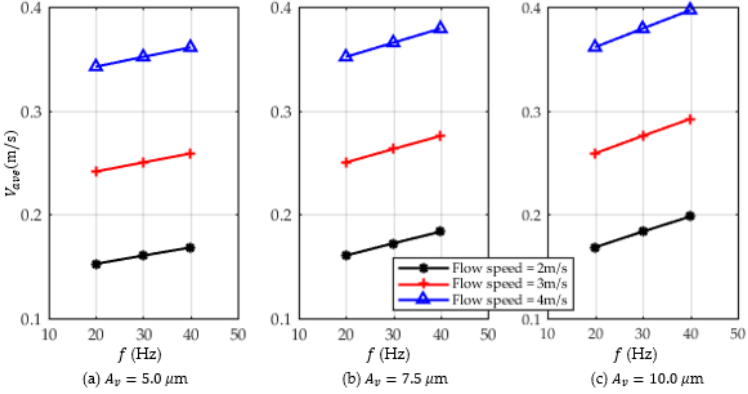
Figure 13b Effect of electrolyte flow speed on particle average flushing speed at every vibration